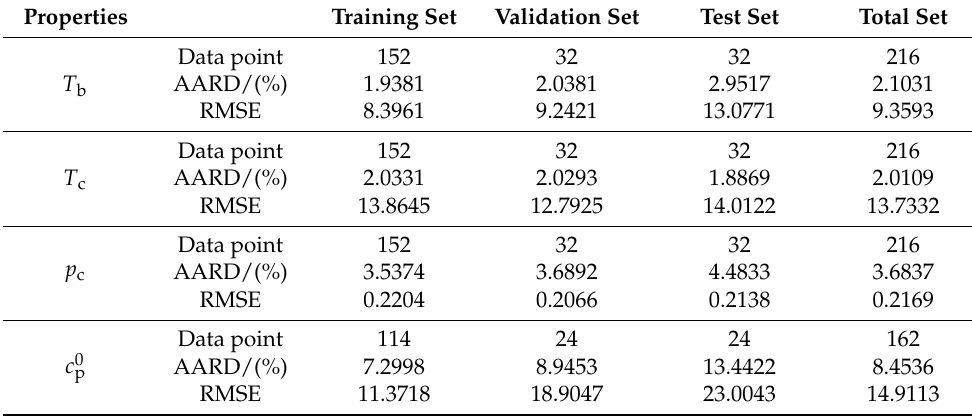
Table 2. Comparison of the statistical parameters for four